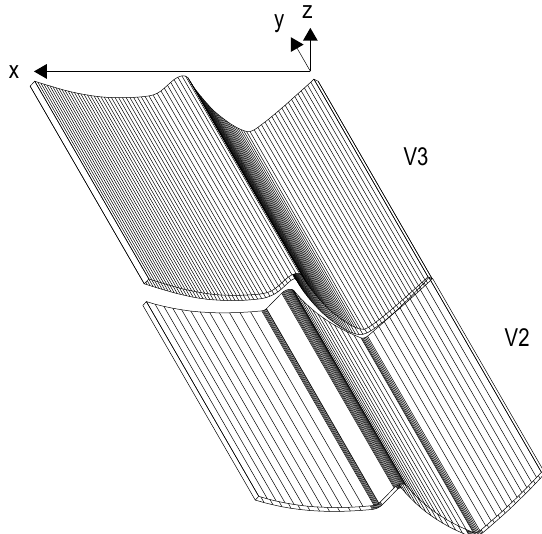
Figure 6. Two variants of the geometric models showing different inclination and profile. First, the model based on the design geometry and inclination ( V2 ). Second, the model incorporating the shape and inclination of the slats as gathered from the manufacturing process ( V3 ). Note the tessellation of the models.